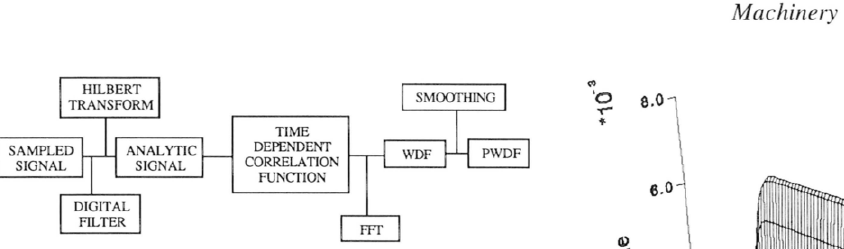
FIGURE 1 Computational block diagram of pseudo Wigner-Ville distribution.